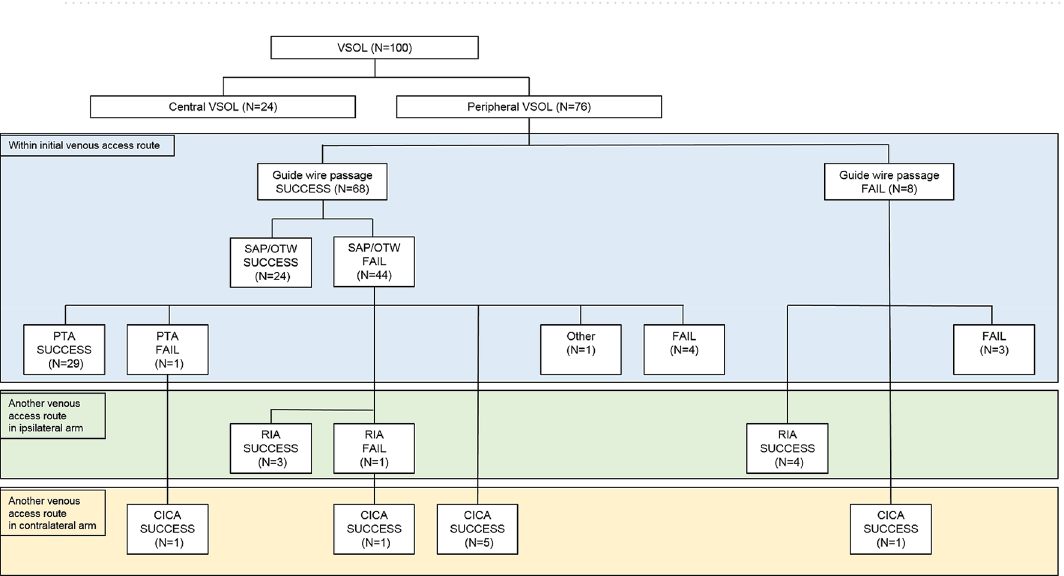
Figure 3. Flow diagram summarizing the various strategies used in patients with peripheral venous steno- occlusive lesion. VSOL venous steno-occlusive lesion, SAP/OTW selecting alternative pathway/over the wire technique, PTA percutaneous transluminal angioplasty technique, RIA re-puncture in ipsilateral arm technique, CICA catheter placement in contralateral arm